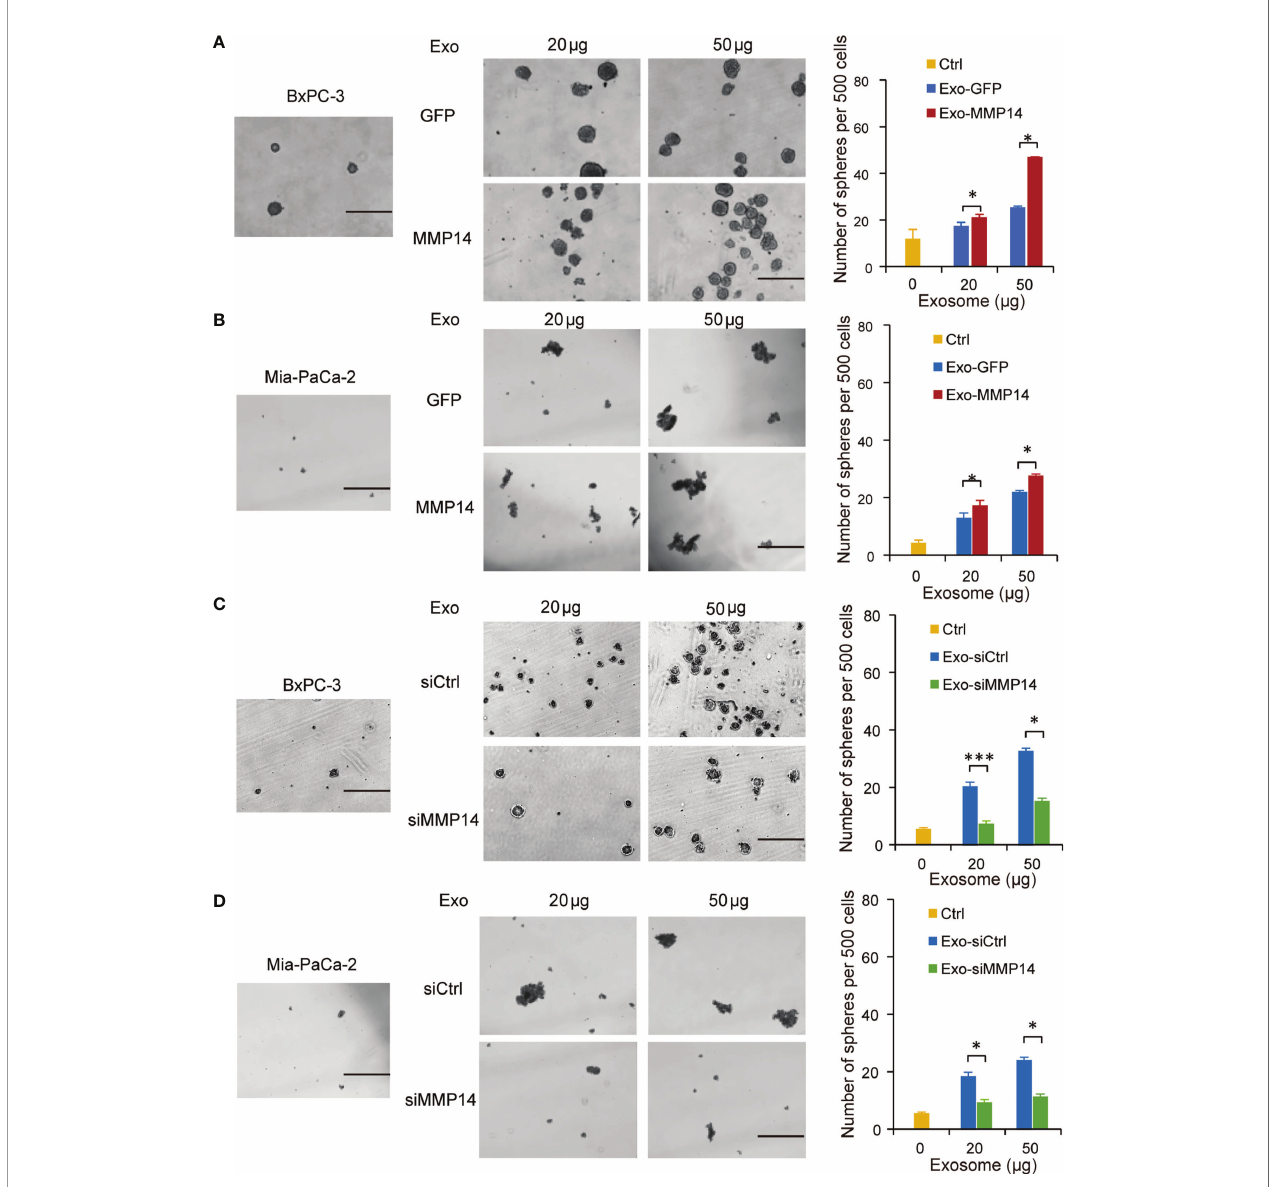
FIGURE 4 | Exosome-transferred MMP14 promotes sphere-formation of the sensitive PDAC cells. (A, B) Sphere-forming assay in BxPC-3 (A) or Mia-PaCa-2 (B) cells incubated with indicated exosomes from MMP14-overexpressing or control PANC-1 cells in a 6-well dish (500 cells per well) for 2 weeks. Representative images (left) from three independent experiments and average number of spheres (right) were shown. (C, D) Sphere-forming assay of BxPC-3 (C) or Mia-PaCa-2 (D) cells with indicated exosomes from MMP14 knockdown or control BxPC-3-Gem cells in a 6-well dish (500 cells per well) for 2 weeks. Representative images (left) from three independent experiments and average number of spheres (right) were shown. Data in A-D are presented as mean ± SD, * P < 0.05, *** P < 0.001. Scale bar, 200 m